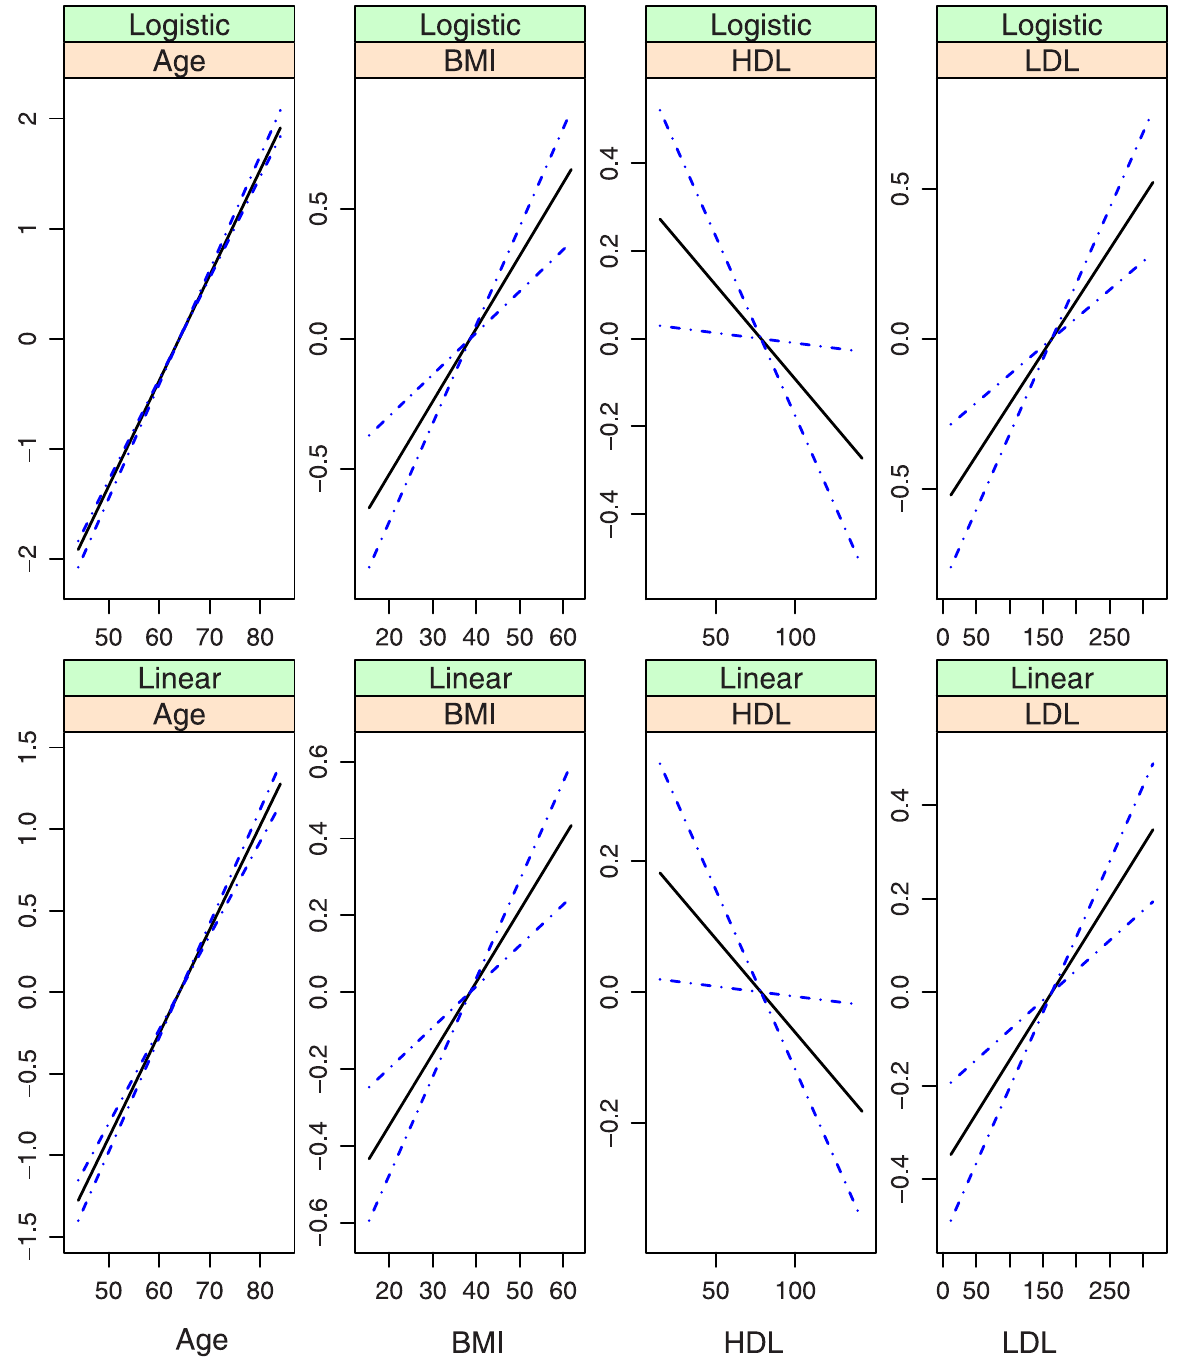
Figure 2. Model (i.1): estimated covariate effects for age, BMI, HDL, and LDL. The solid line is the estimate. The dash-dotted lines are the point-wise 95% confidence intervals. The y-axis is the value of the function. doi:10.1371/journal.pone.0012036.g002 where numbers in the ‘‘()’’ are the standard deviations. The overall MSEs are